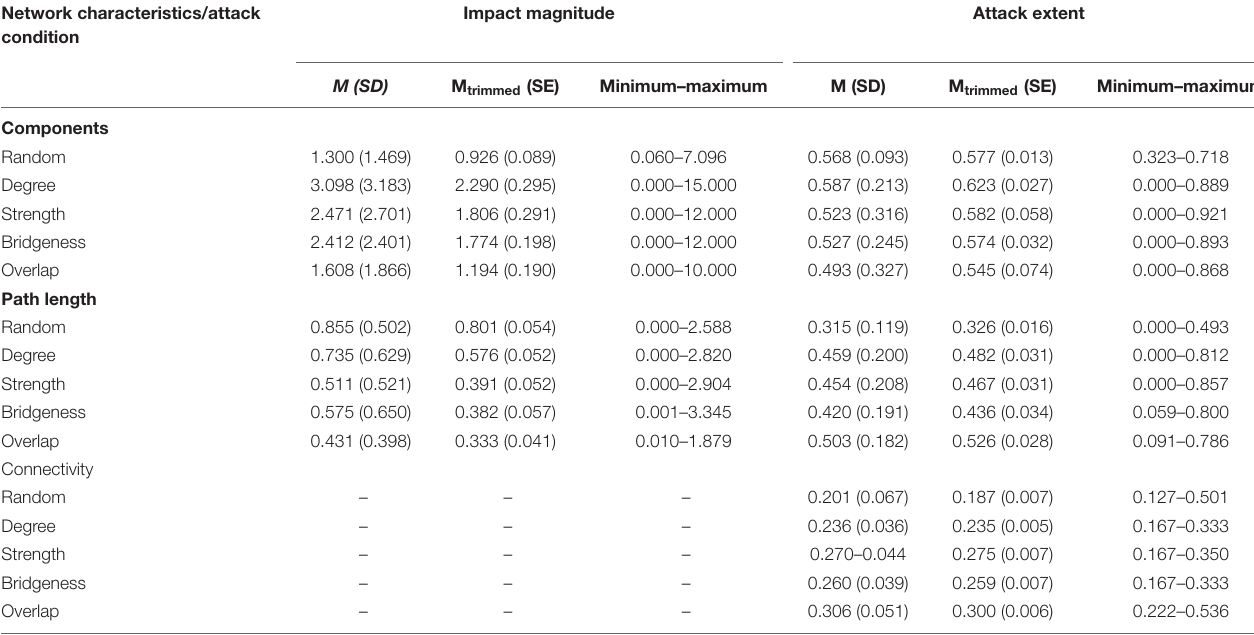
TABLE 2 | Descriptives of impact magnitude and attack extent.